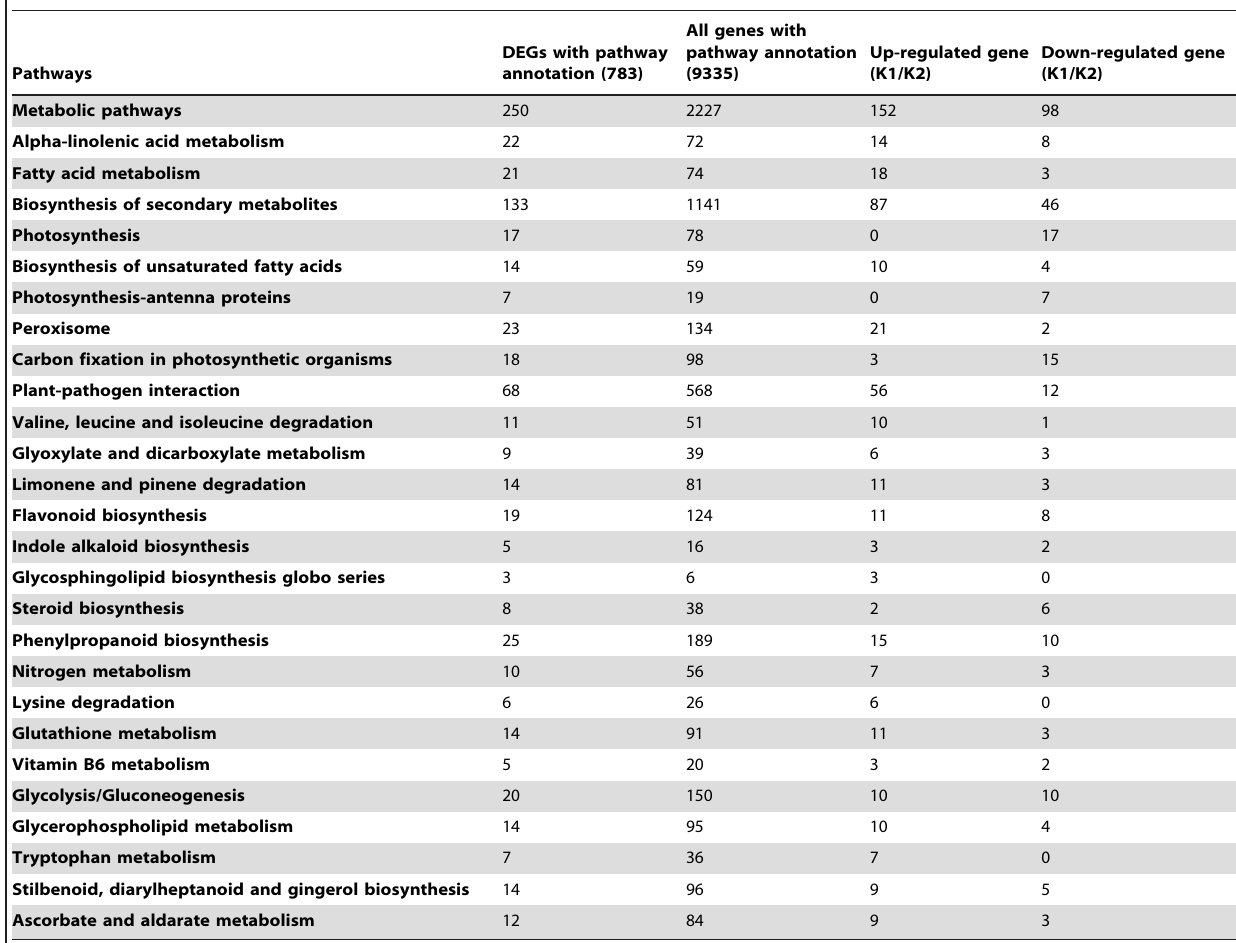
Table 2. KEGG pathway annotation of differentially expressed genes obtained from Solexa